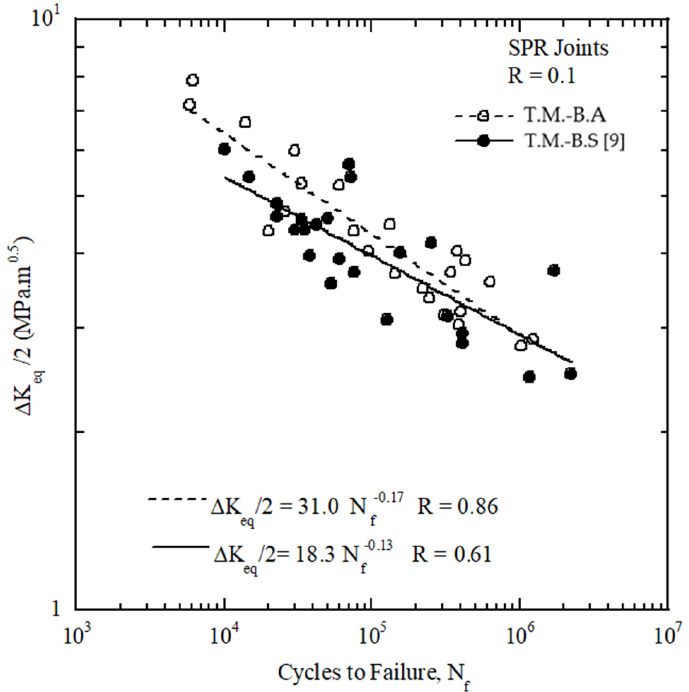
Figure 16. Comparison of the fatigue lifetimes of the T.M-B.A and T.M-B.S [9] SPR joints under three loading conditions.